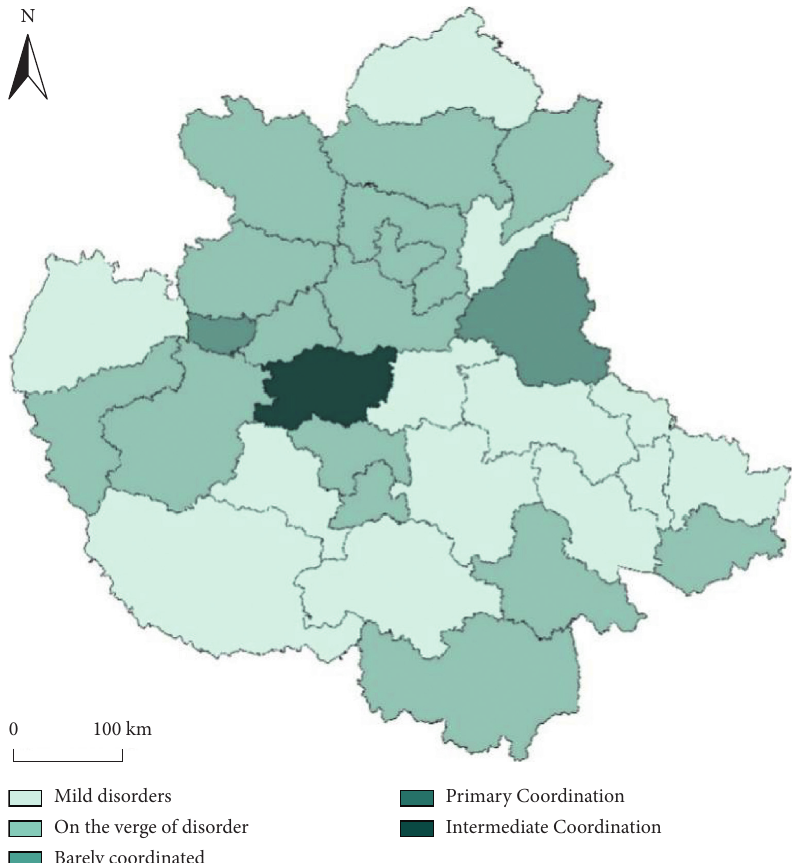
Figure 3: Spatial pattern of logistics industry and economic coupling coordination in the Central Plains City